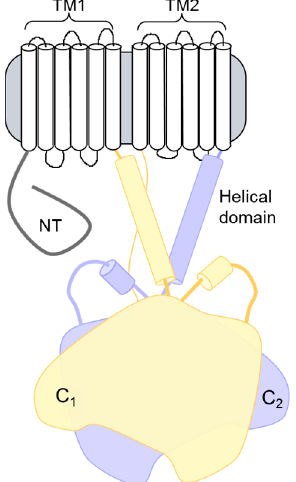
Figure 1. Topology of adenylyl cyclase (AC) isoforms. The structural topology of mammalian membranous ACs consists of an N-terminal (NT) domain followed by a repeating set of transmembrane, helical dimerization, and cytoplasmic domains. The two cytoplasmic domains (C1 and C2) make up the catalytic core and the binding site for many regulatory proteins.